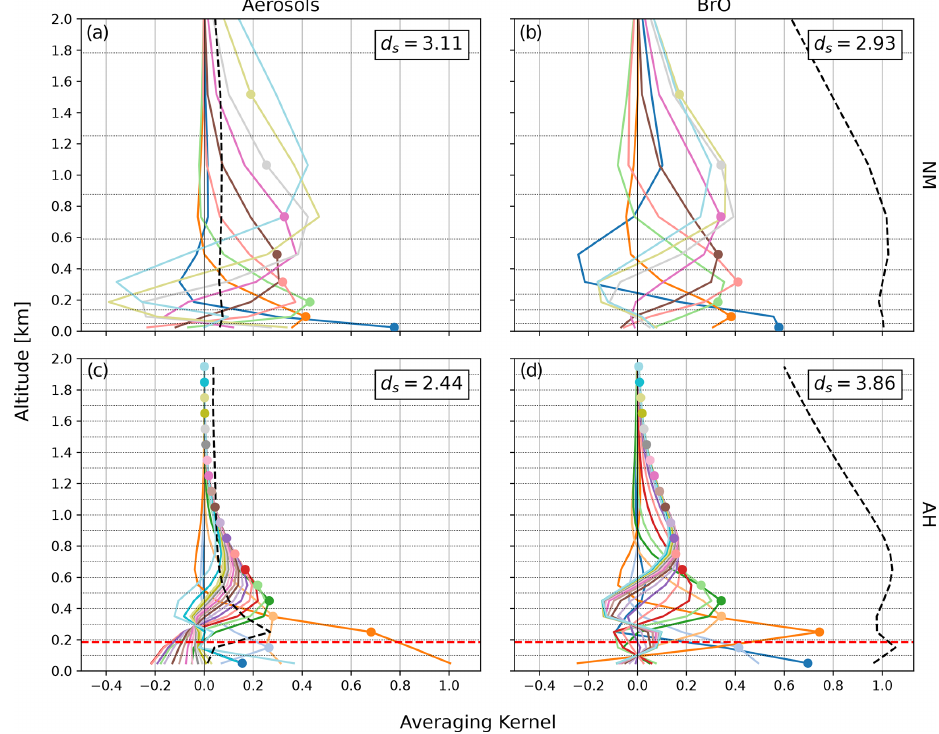
Figure 2. Examples of clear-sky AVKs for aerosols (a, c) and BrO (b, d) . Panels (a) and (b) show AVKs for NM on 2 November 2021, 13:30UTC, with an aerosol optical depth (AOD) of 1 . 99 × 10 − 3 . Panels (c) and (d) show AVKs for AH on 25 November 2018, 01:30UTC, with an AOD of 2 . 66 × 10 − 2 . Each colour shows the AVK for an individual height layer, with its nominal height indicated by a coloured dot. The dashed lines show the averaging kernels of the total column in kilometres. Layer boundaries are shown as dotted horizontal lines. The dashed red lines in (c) and (d) indicate the height of the AH instrument above sea level.